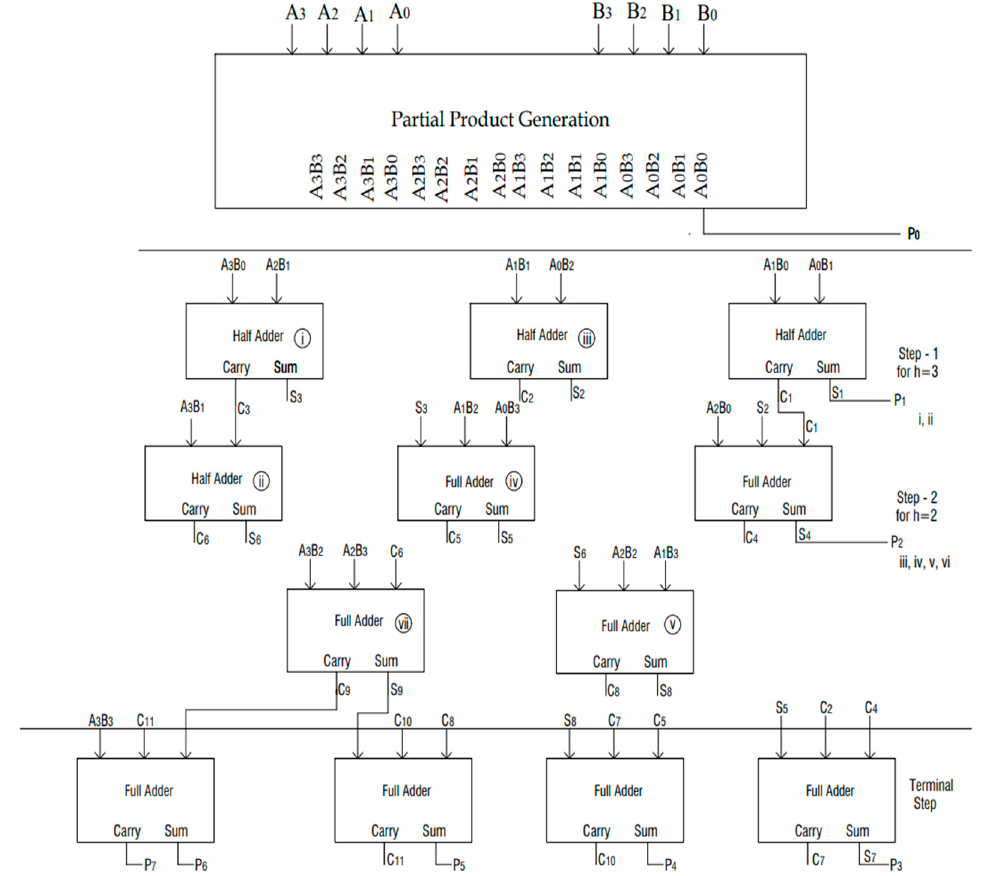
Figure 4. Schematic design of 4 × 4 Dadda multiplier.